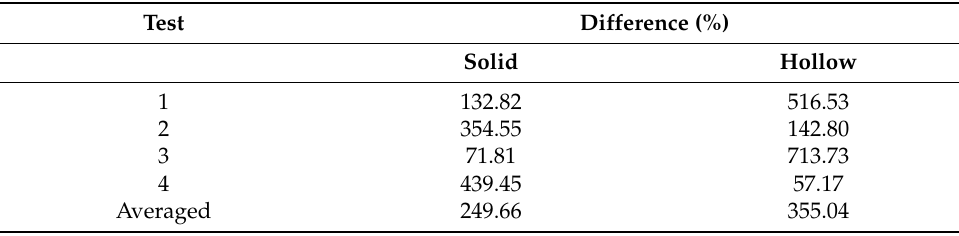
Table 2. Difference (relative to 0 s for each condition) at 3500 Hz.